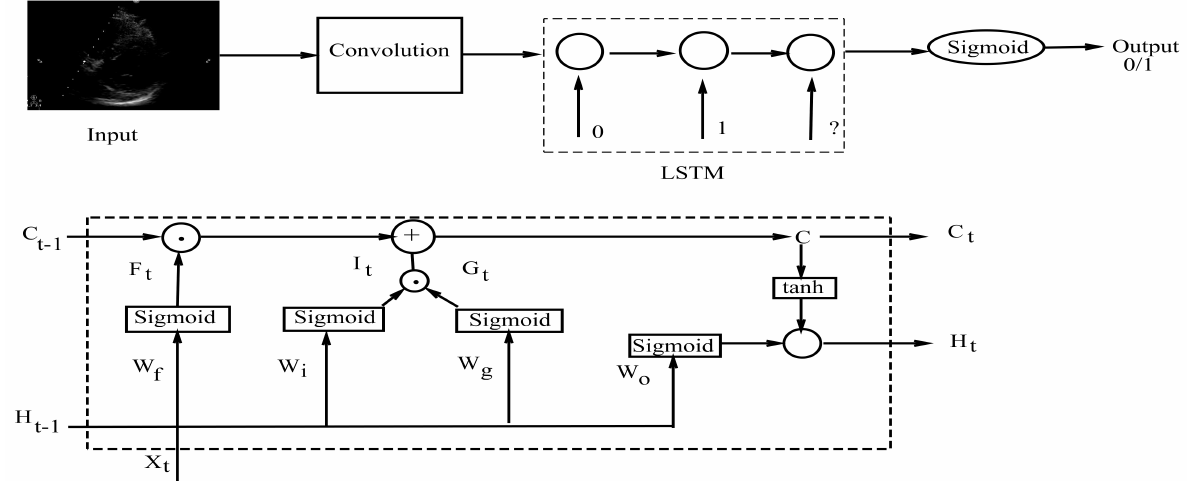
Figure 3. Long Short Term Memory (LSTM) diagram with an overall flowchart of how the model works where an input image is passed to a convolution layer, then it is forwarded to the architecture whereby images are classified based on the previous and present